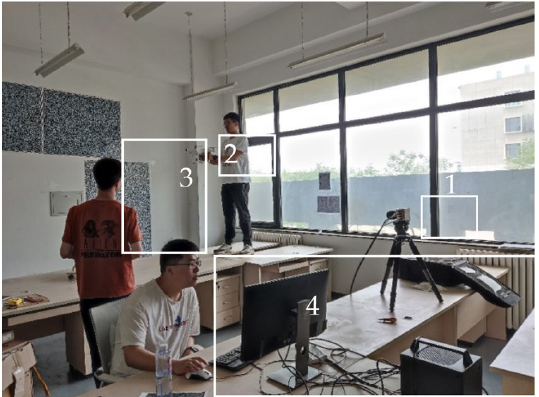
Figure 14. UAV measurement setup. ( 1 ) High-speed camera and 35 mm lens. ( 2 ) Handheld UAV. ( 3 ) Speckle background plate. ( 4 ) Data operation and storage industrial control machine (including input and output